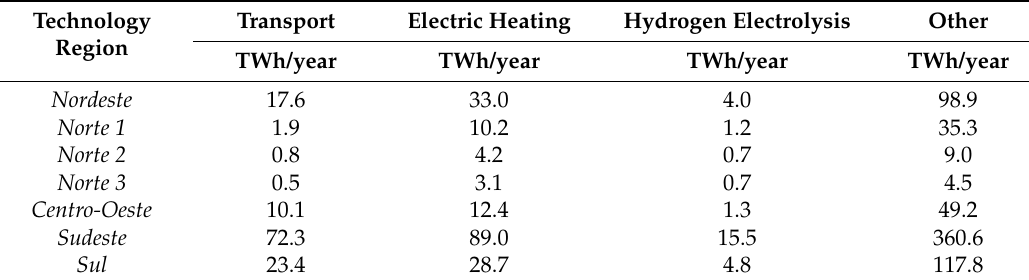
Table A3. Considered regional annual power demand based on [41].